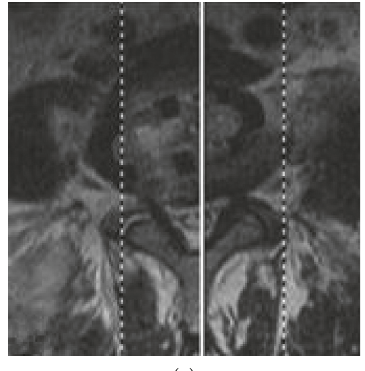
Figure 7: A representative case of OLIF surgery. A patient with degenerative lumbar spondylolisthesis (L4-5, a–c) underwent OLIF surgery (d, e). One year after the operation, fusion and trabeculae were formed with the cage in a desired position (f,